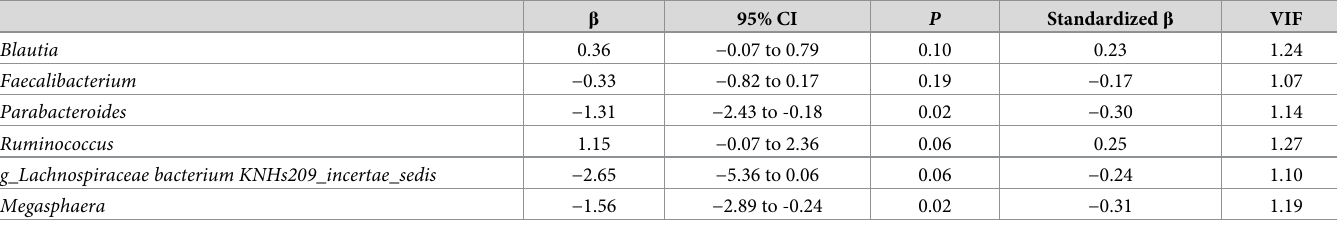
Table 4. Multiple regression analysis calculating the associations between the microbiota and the PSQ total score (n = 56). β 95% CI P Standardized